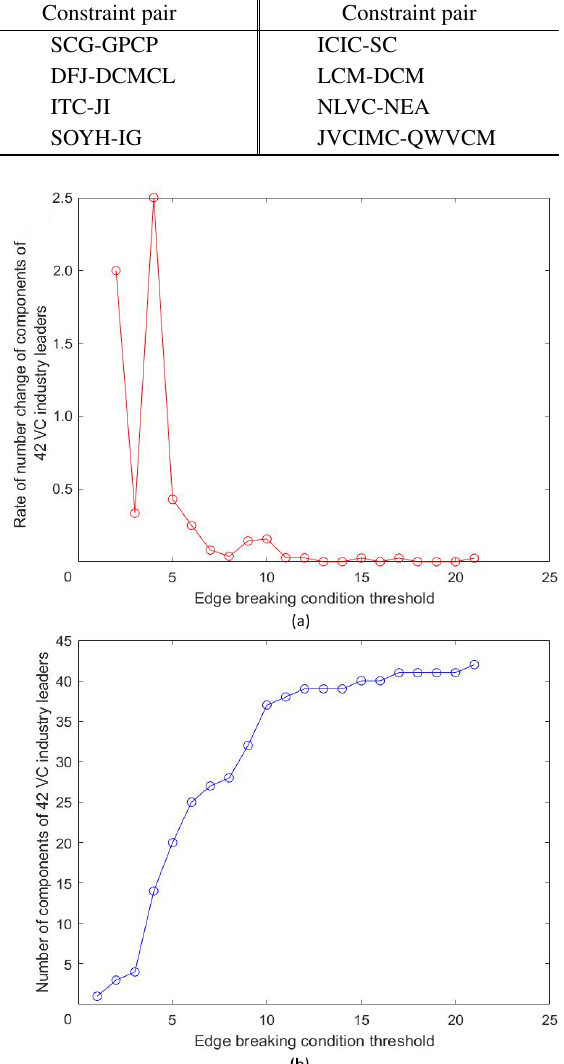
Table 1 Constraint pairs among 42 VC industry leaders.